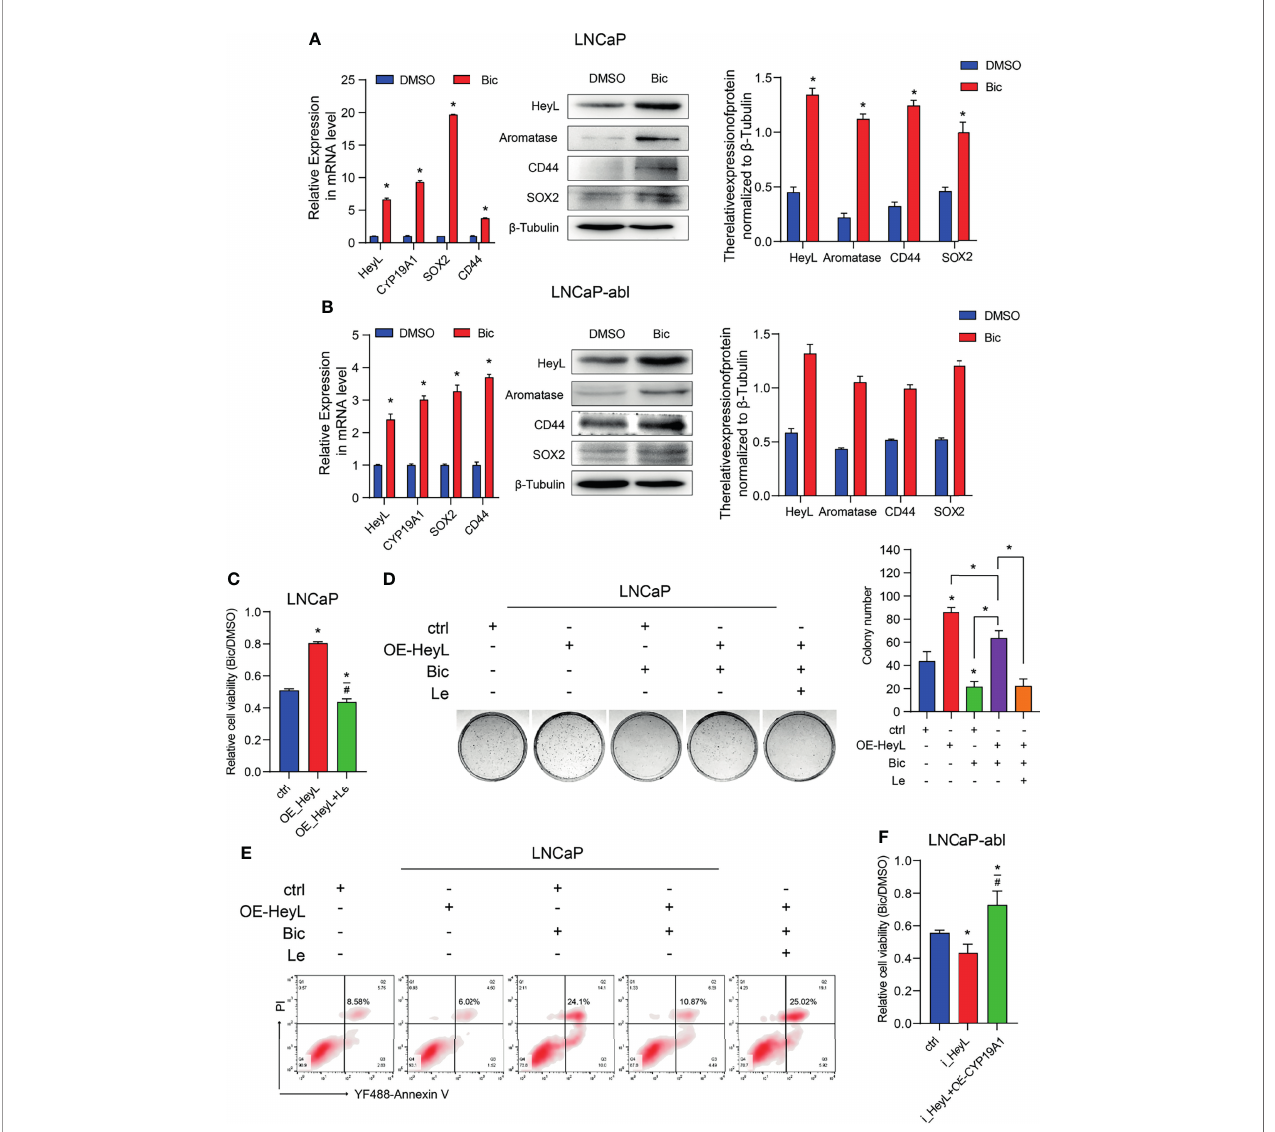
FIGURE 5 | Blocking the HeyL-aromatase axis sensitizes PCa cells to bicalutamide treatment. (A, B) The mRNA (left panel) and protein (right panel) levels of HeyL, aromatase, SOX2, and CD44 were analyzed in LNCaP (A) and LNCaP-abl (B) cells treated with bicalutamide (t-test). (C) Cell viability was evaluated in LNCaP cells after the indicated treatments (one-way ANOVA). (D) The clonogenic ability of vector control and HeyL-overexpressing LNCaP cells treated with bicalutamide and/or letrozole was analyzed (one-way ANOVA). (E) Vector control LNCaP cells and HeyL-overexpressing LNCaP cells were treated with bicalutamide and/or letrozole. Apoptosis was evaluated by fl ow cytometry. (F) Cell viability was evaluated in LNCaP-abl cells after the indicated treatments (one-way ANOVA). The data are presented as the mean ± SD values (n=3). * p < 0.05 vs. ctrl. # p < 0.05 vs.